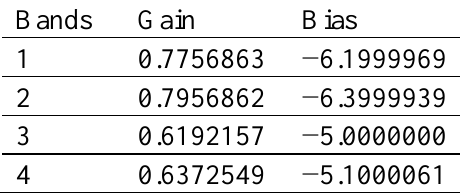
Table 2. Spectral values of bias and gain from the Landsat ETM+ image header